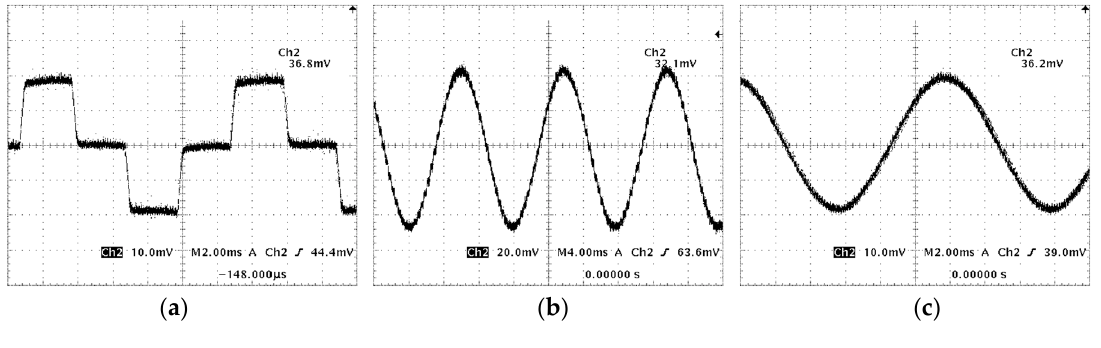
Figure 15. Measured phase current waveforms at speed of 100 rpm under different divides of micro- stepping drive. ( a ) N d = 4; ( b ) N d = 32; ( c ) N d = 256.